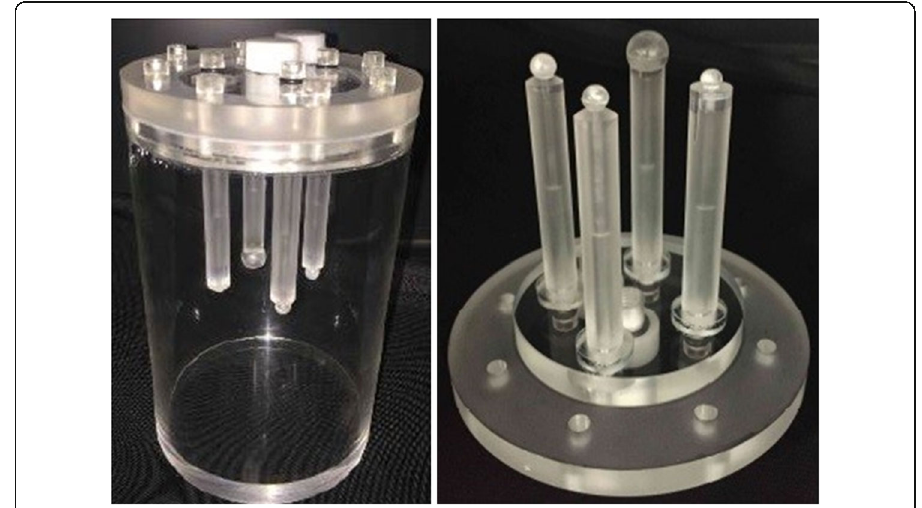
Fig. 1 A cylindrical breast phantom with four spheres of various diameters (5, 7.5, 10, and 16